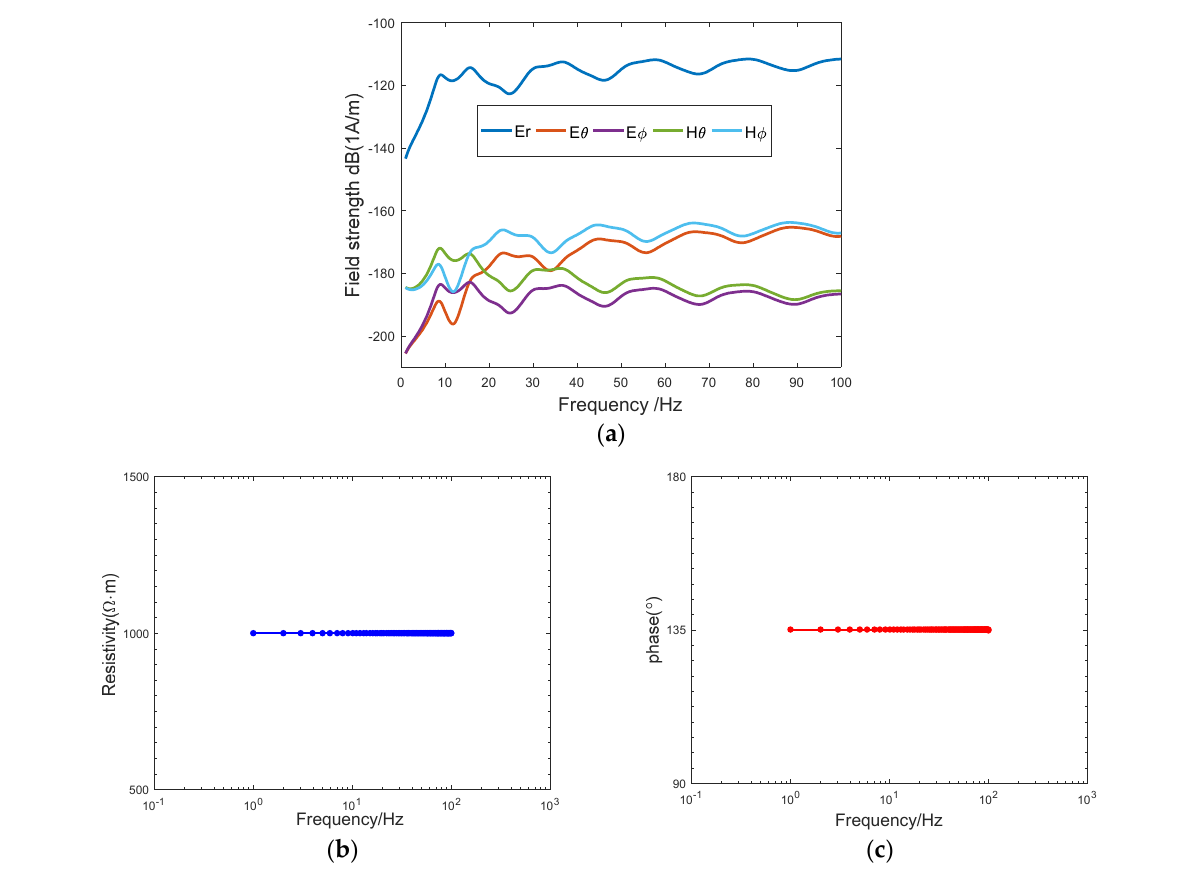
Figure 6. ( a ) Response of the EM fields generated by artificial sources in the Earth–ionosphere cavity as a function of transmitting frequency from 1 to 100 Hz and when the observation azimuth is θ = 2 π /3, and ( b ) apparent resistivity: ρ = 1